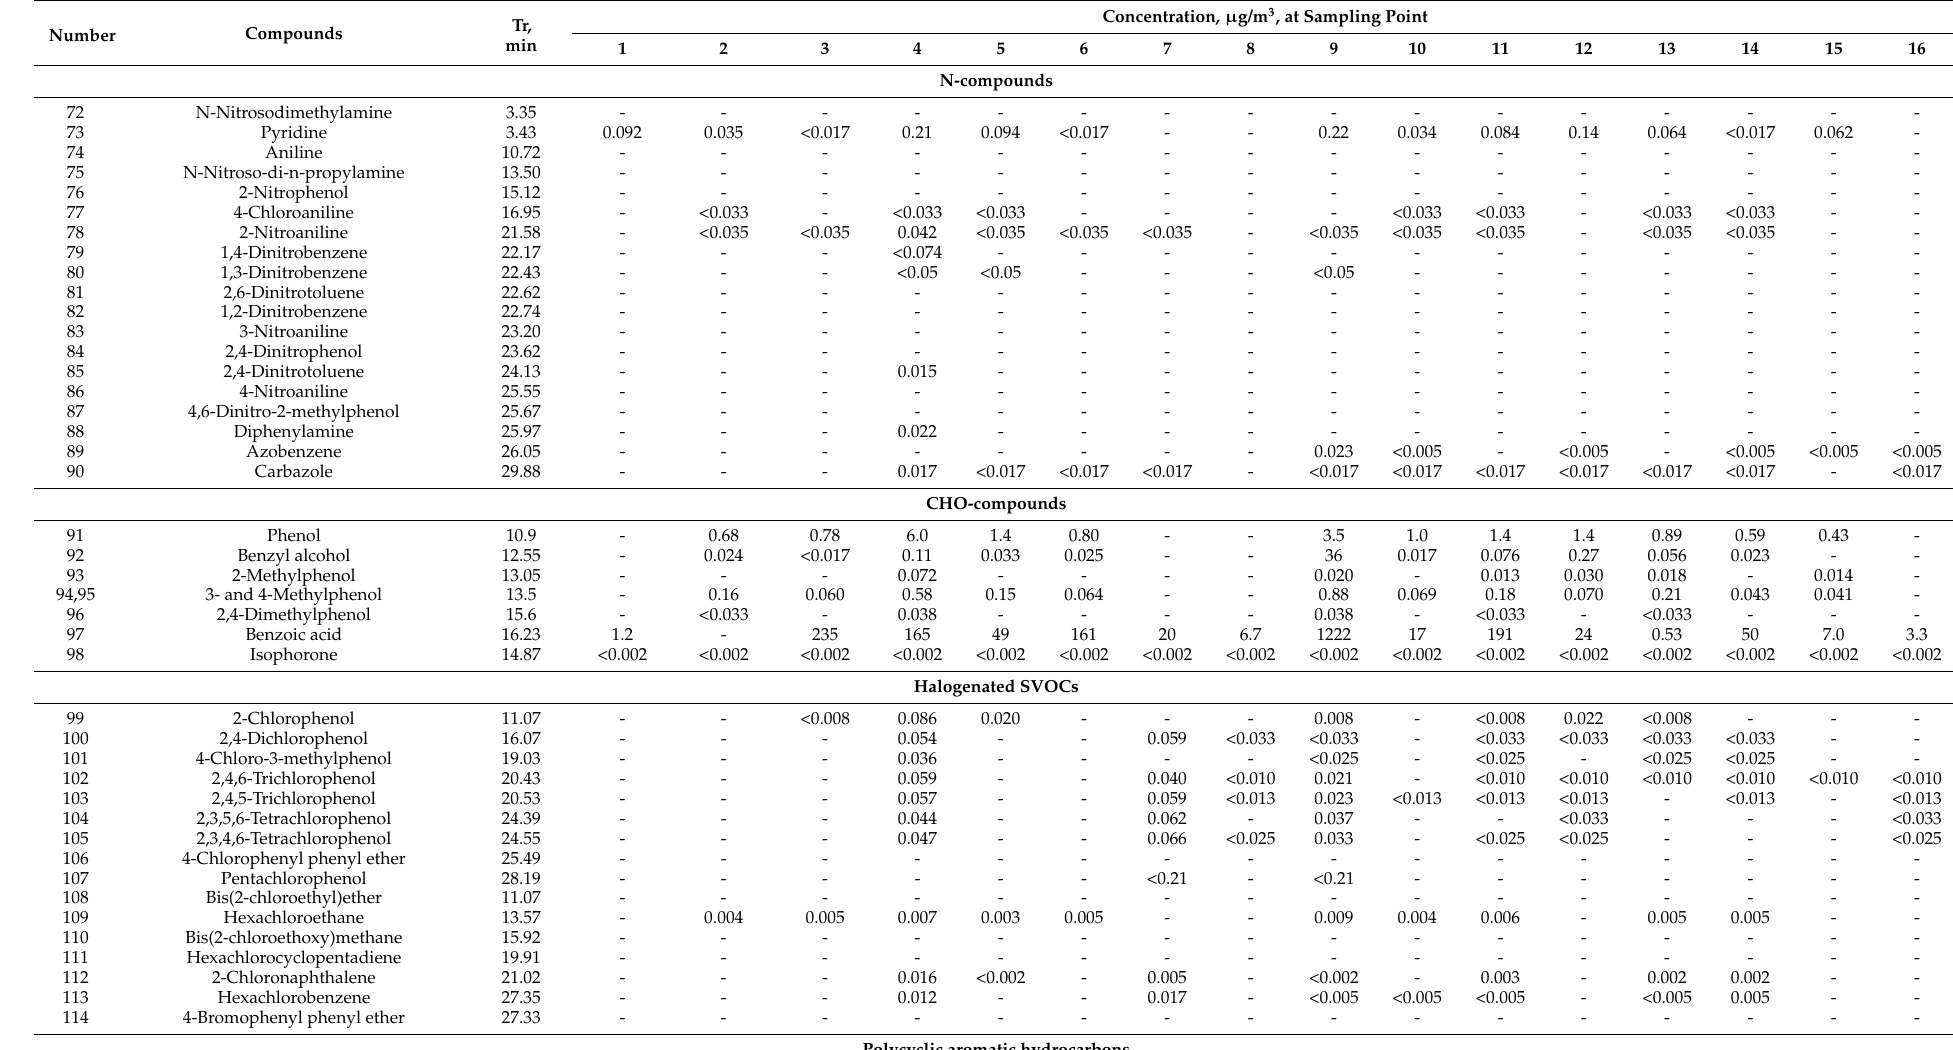
Table 2. Concentrations of semi-volatile organic compounds in the air samples measured by